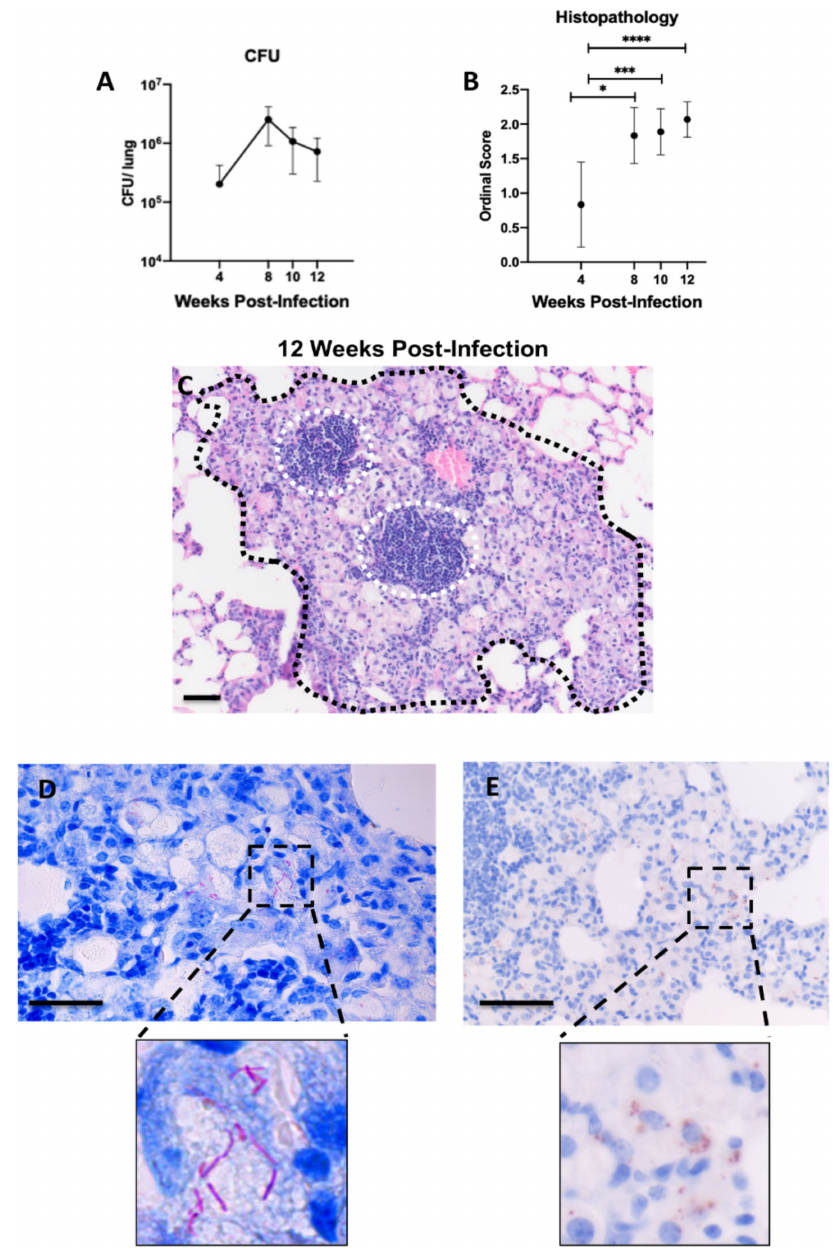
Figure 1. Establishment of chronic pulmonary M. avium infection with intranasal inoculation 4–12 weeks post-infection (wpi) in B6.Sst1S mice. ( A ) CFU/lung following intranasal (IN) 10 6 inoculation; ( B ) histopathology scores of 10 6 CFU IN M. avium inoculated mice at 4, 8, 10, and 12 wpi; ( C ) representative histological micrograph of granulomatous lesion (black hash) with intralesional lymphoid aggregates (white hashed circles) caused by M. avium at 12 wpi assessed by hematoxylin and eosin (H&E) and visualized using brightfield microscopy; ( D ) detection of M. avium Acid-fast bacilli using Ziehl-Neelsen stain and visualized using brightfield microscopy; ( E ) diaminobenzidine (DAB) immunohistochemistry detection of Mycobacterial antigen visualized using brightfield mi- croscopy. High magnification insets are located below ( D , E ) to highlight distinct differences in these modalities utilized to visualize mycobacterium bacilli and antigen respectively. For ( A ), each data point represents average CFU/lung; n = 6 (4 wpi), n = 2 (8 wpi), n = 3 (10, 12 wpi). For ( B ), each data point represents the mean from a single tissue section; n = 18 (4 wpi), n = 6 (8 wpi), n = 9 (10 wpi), n = 15 (12 wpi). Data are expressed as means ± SD. * p < 0.05, *** p < 0.0005, and **** p < 0.00005. Original magnification, 100 × ( C ) and 200 × ( D , E ); scale bars = 50 µ